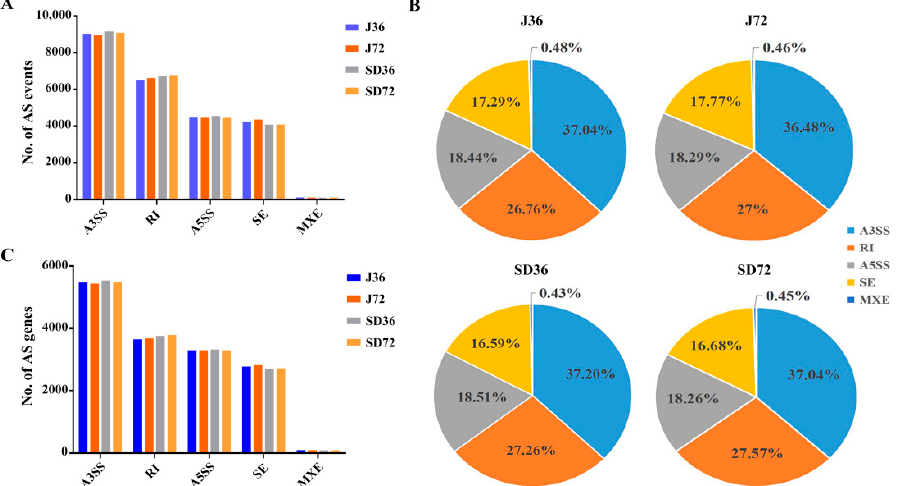
Figure 2. Summary of AS events and genes in apple. ( A ) The number of five AS events in response to A. alternata AP infection in apples. Color scale represents J36, J72, SD36 and SD72 groups, respectively. ( B ) The distribution of five AS events in J36, J72, SD36 and SD72 groups. Color scale represents A3SS, RI, A5SS, SE and MXE AS event types, respectively. ( C ) The number of five AS genes in response to A. alternata AP infection in apples. Color scale represents J36, J72, SD36 and SD72 groups, respectively.